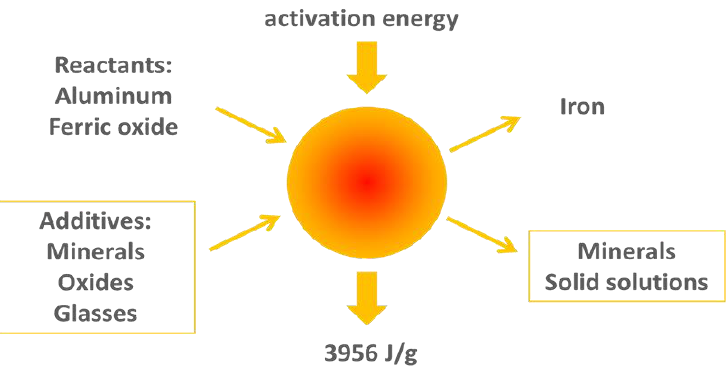
Figure 4. Aluminothermite reactants, products, and energy release.